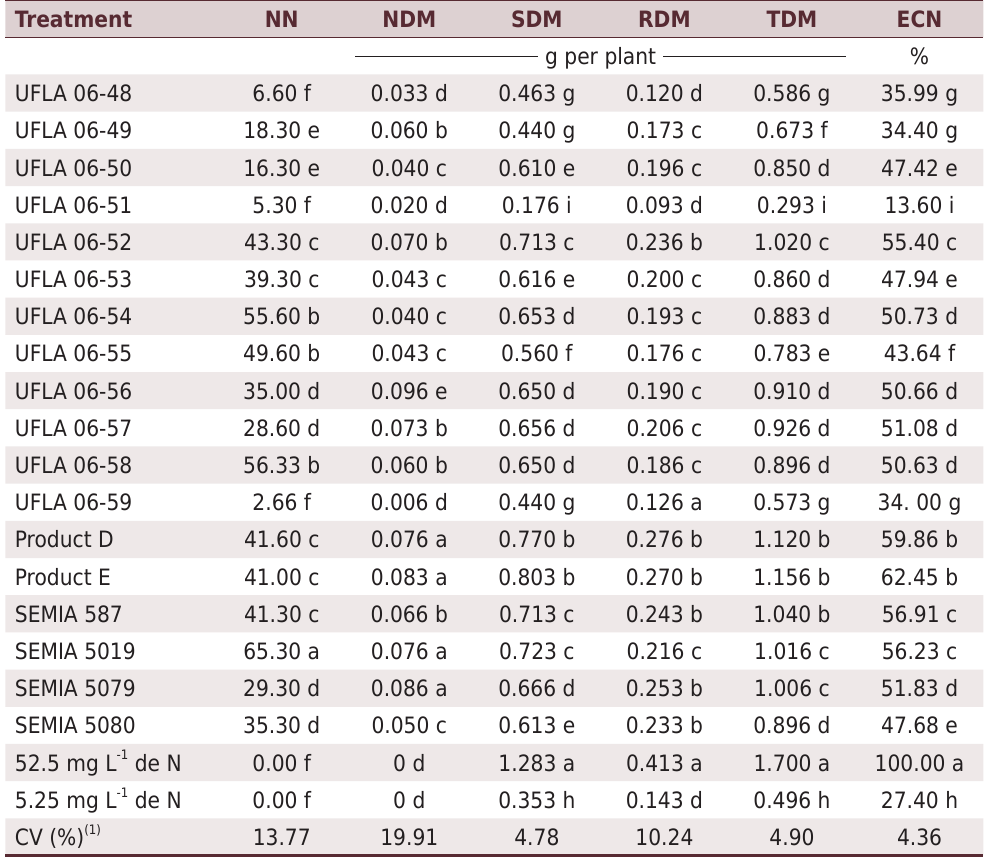
Table 4. Number of nodules (NN), nodule dry matter (NDM), shoot dry matter (SDM), root dry matter (RDM), total dry matter (TDM), and relative efficiency (ECN) of soybean plants cultivated in glass bottles with different treatments: strains isolated from inoculants, inoculant products D and E, two uninoculated controls, one with high mineral N concentration (52.5 mg L -1 ) and one with low mineral N concentration (5.25 mg L -1 ), and four controls inoculated with strains approved as soybean inoculants: B. japonicum (SEMIA 5079), B. diazofficiens (SEMIA 5080), and B. elkanii (SEMIA 587 and SEMIA